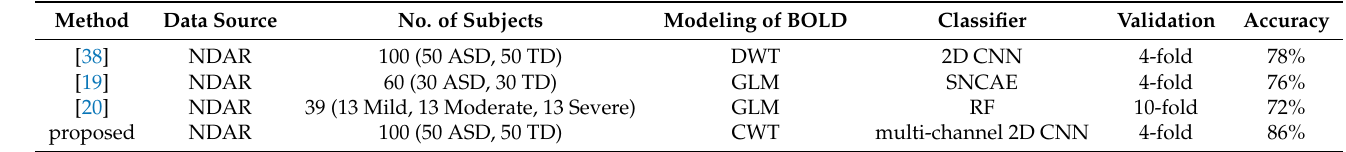
Table 4. A comparison of the proposed CAD system with other GLM-based